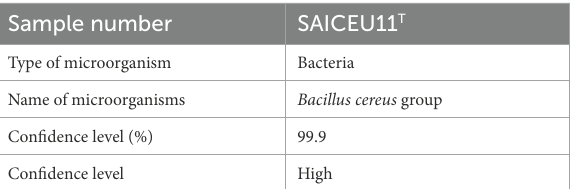
TABLE 9 Report of matrix-assisted laser desorption/ionization time- of-flight (MALDI-TOF)